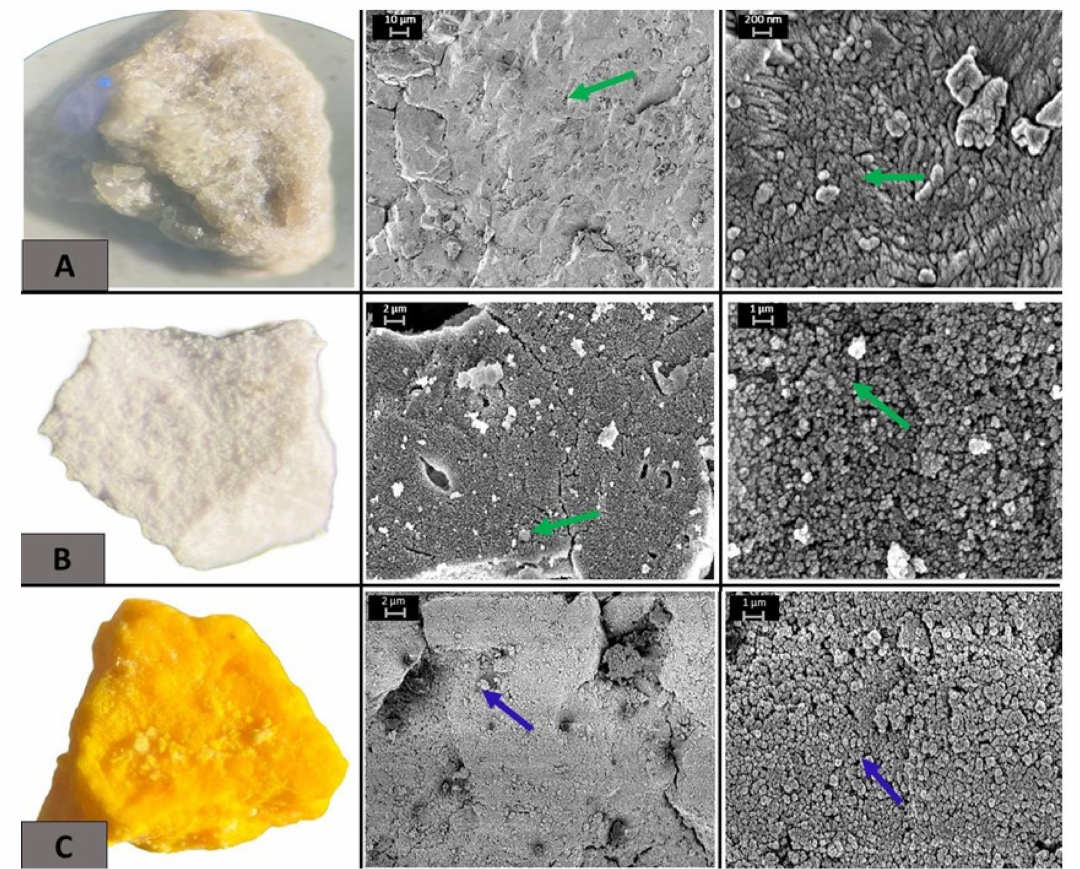
Figure 3. Raw and activated dolomite before and after being treated with RTDW and STDW us- ing a dissecting microscope (DM—left picture) and Field Emission Scanning Electron Microscopy (FESEM—middle and right picture). Raw dolomite = inactivated dolomite. Bar (FESEM) = 10 µ m and 200 nm ( A ); Control: untreated activated dolomite at 700 ◦ C. Bar (FESEM) = 1 µ m and 2 µ m ( B ); Activated dolomite treatment in RTDW and STDW. Bar (FESEM) = 1 µ m and 2 µ m ( C ). Blue arrows indicate dye compound adsorption on dolomite (dense clumping on pores). Green arrows indicate no dye compound